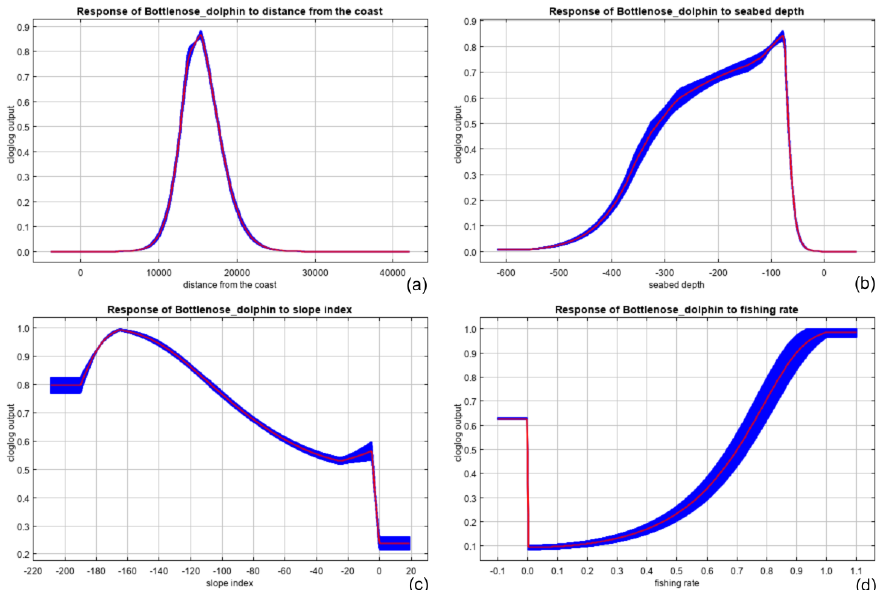
Figure 3. MaxEnt response curves for bottlenose dolphins, showing the probability of presence